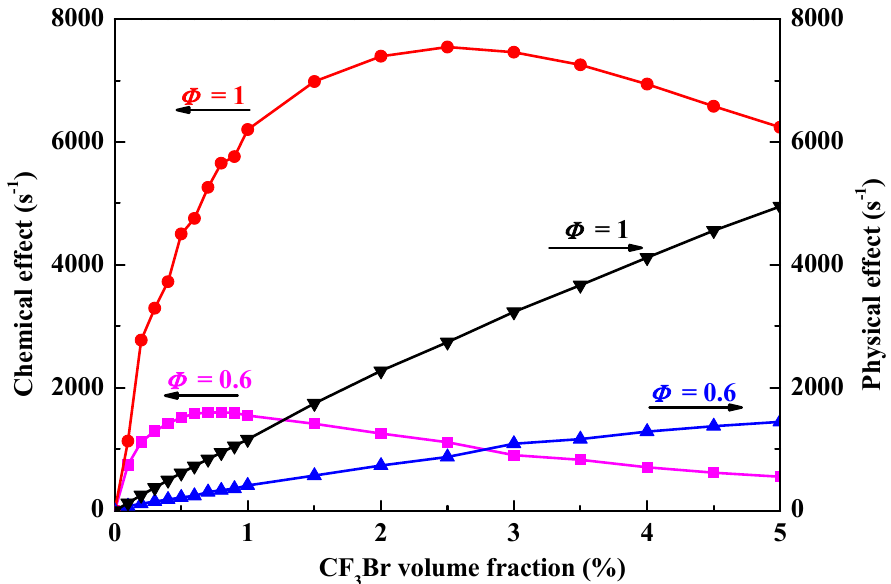
Figure 3. The chemical effect (left scale)/physical effect (right scale) as a function of CF 3 Br volume fraction in stoichiometric and lean ( Φ = 0.6) CH4/air flames at 298 K and 1 bar.